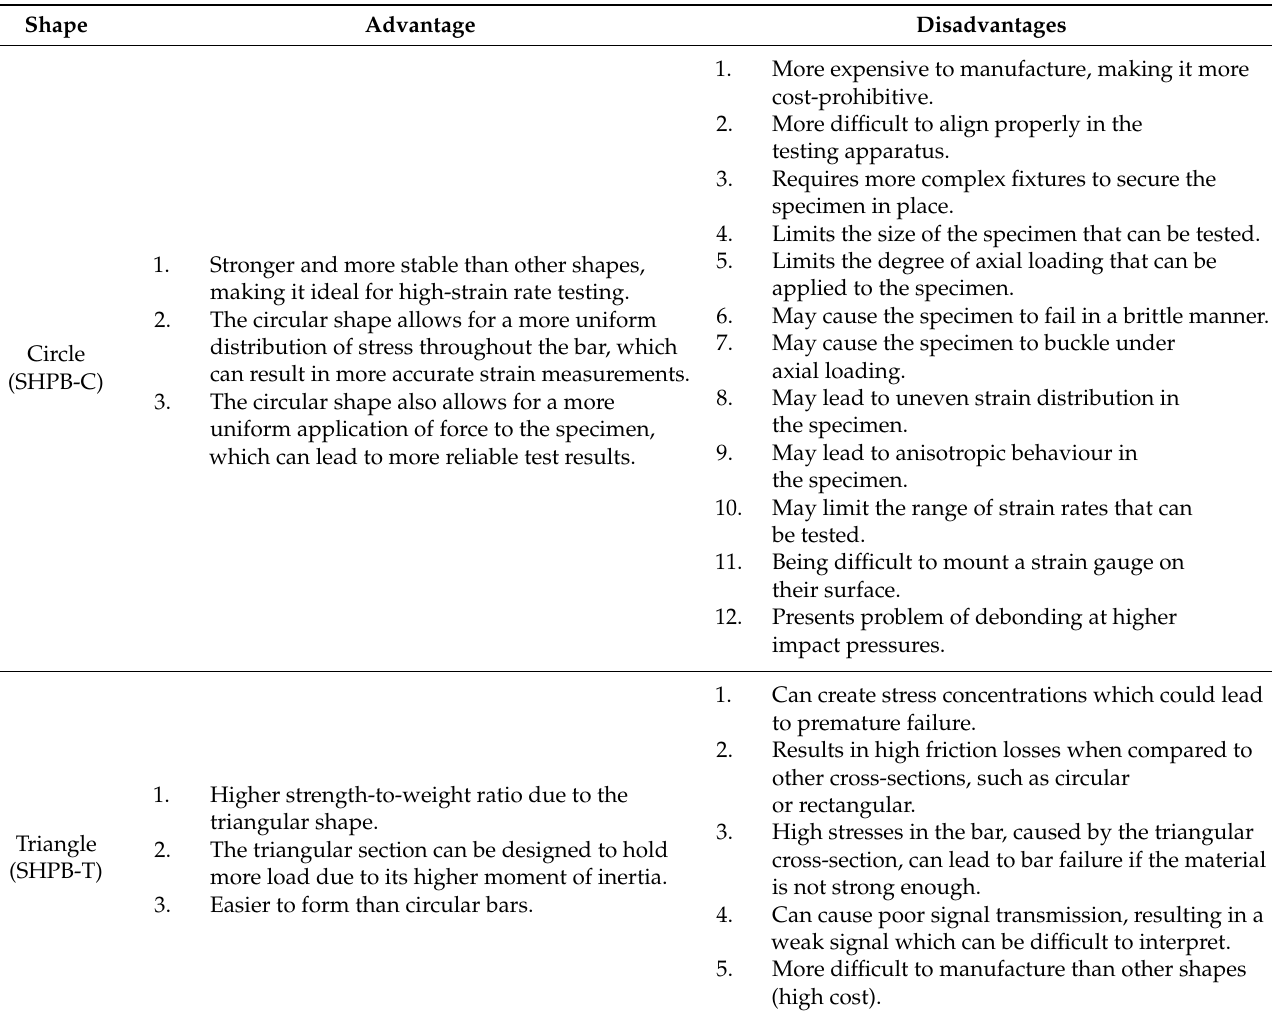
Table 5. Advantage and disadvantages of the different SHPB